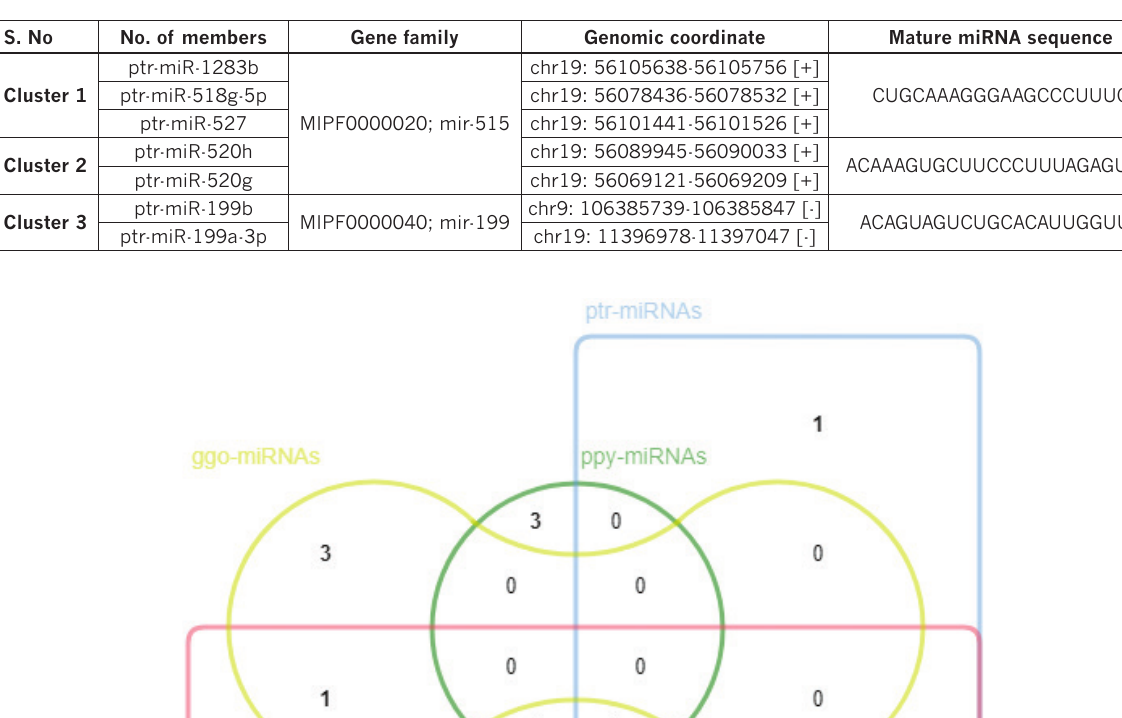
Table 4. List of miRNAs grouped into clusters, their genomic coordinates, gene family names and their matured miRNA sequences in Pan troglodytes .